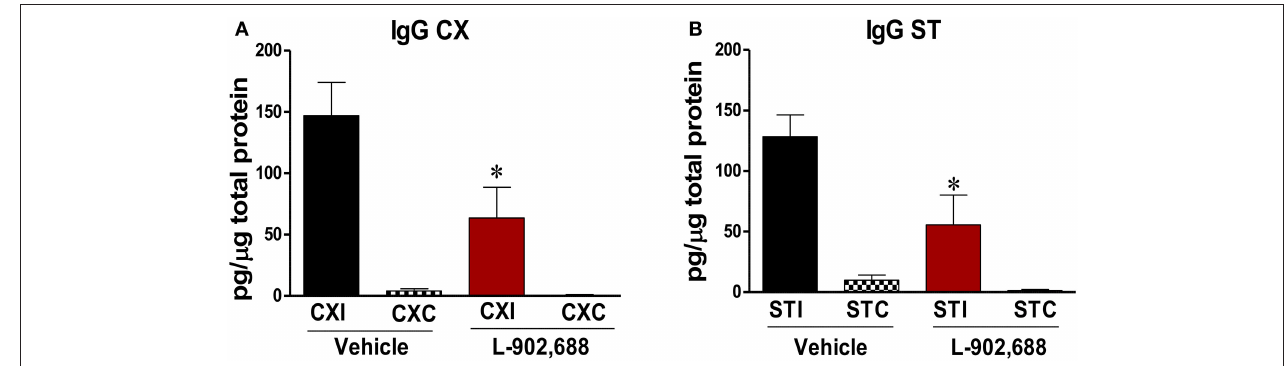
FIGURE 2 | Reduced IgG in the brain in stroked rats treated with the EP4 Agonist L-902,688. (A) There is significantly reduced IgG after 24h of reperfusion in the 1.0 mg/kg L-902,688 CXI group compared to the vehicle CXI group. (* P = 0.0413). (B) In animals receiving 1.0 mg/kg L-902,688, the ipsilateral subcortical IgG levels are also significantly reduced. (Student’s t- test * P = 0.0254). CXI, ipsilateral cortex; CXC, contralateral cortex; STI, ipsilateral subcortex; STC, contralateral subcortex. Vehicle ( n = 10) and 1.0 mg/kg L-902,688 ( n =